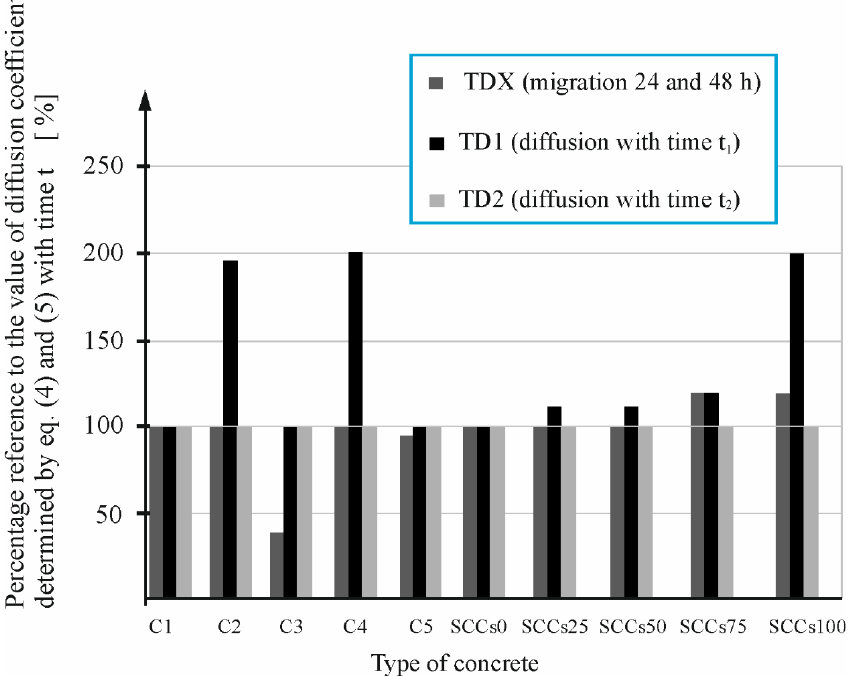
Figure 9. Percentage reference of diffusion coefficient (TDX) and values determined by Equations (4) and (5) at time t 1 (TD1) and time t 2 (TD2) to the reference value determined at time t 2 (TD2): in C1-C5 concretes and SCCs0 - SCCs100 concretes. Figure 10 shows the percentage ratio of the diffusion coefficient D 1 (TDX) deter- mined after short migration tests based on the thermodynamic migration model [48] in relation to the diffusion coefficient D t2 (TD2) determined after a longer diffusion time using the curve fitting method NT BUILD 443 [5] for the concretes: C6, C7, C8, SCC1, SCC2, SCC3, SCC4, CP1, CP2, and HSC1.